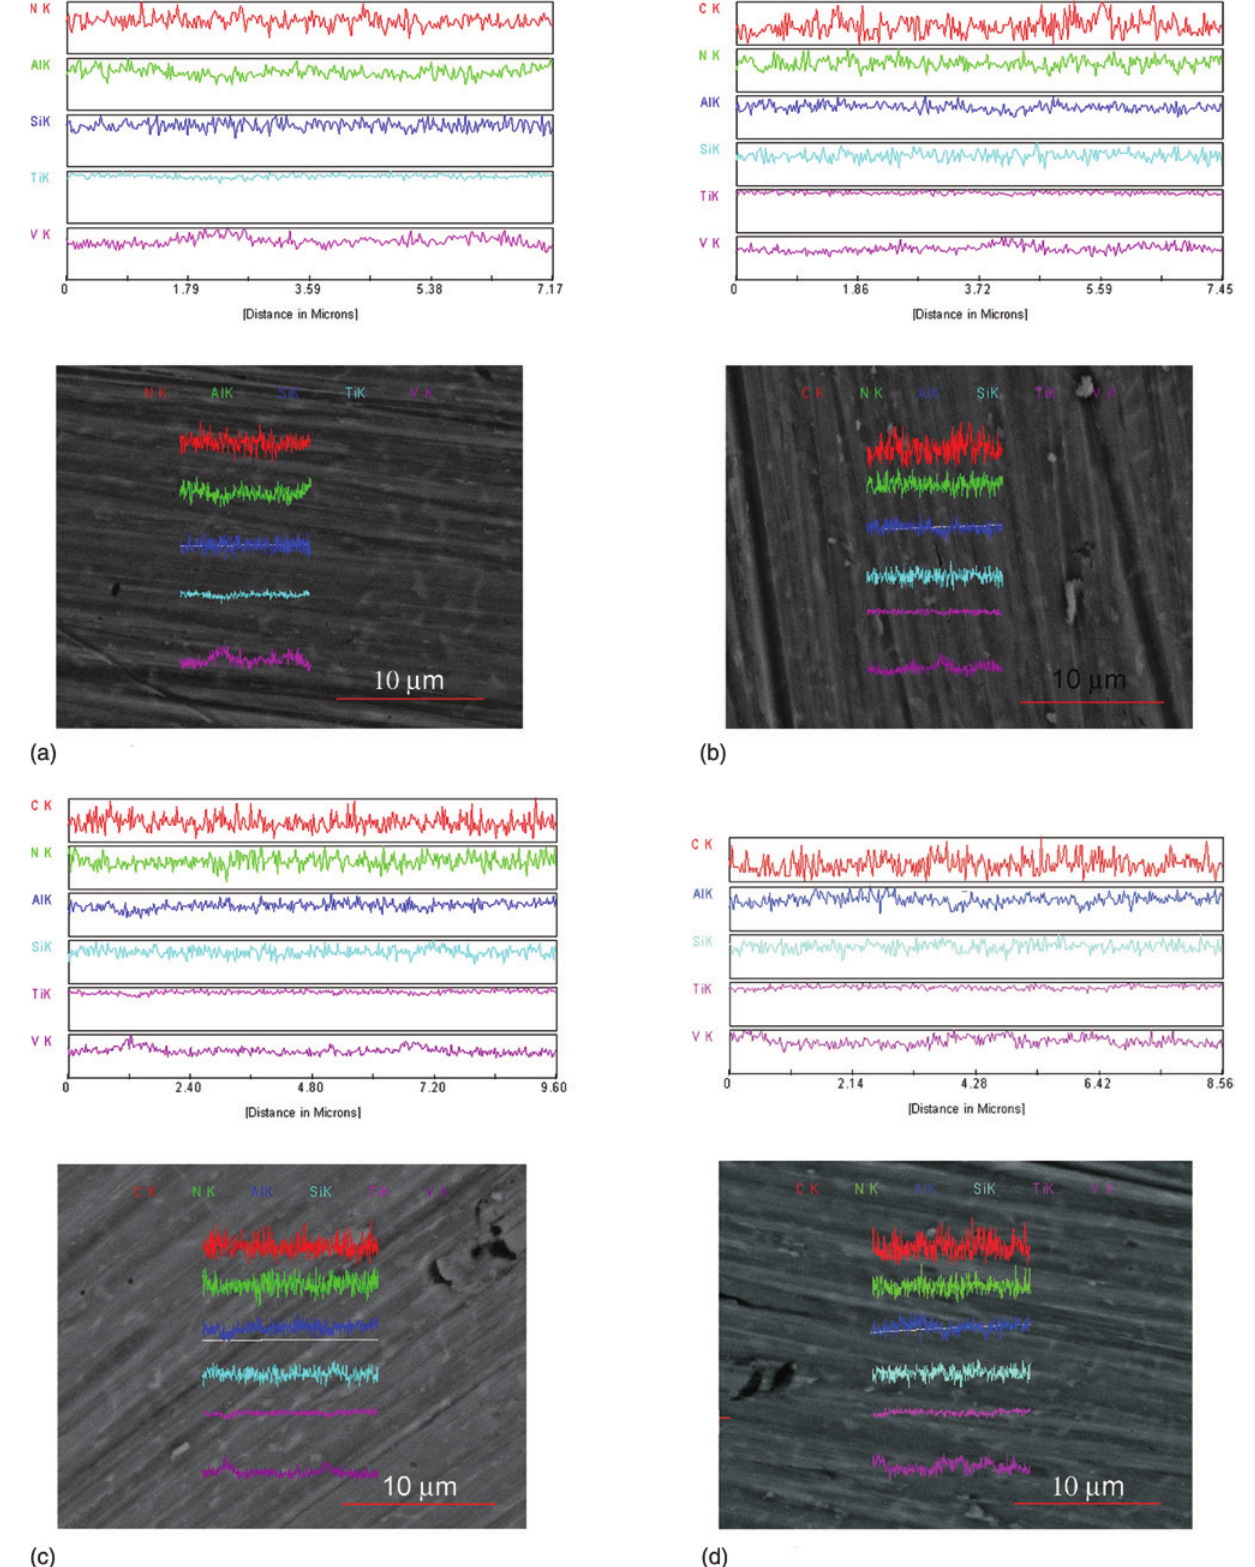
Fig. 2: The linear distribution of elements in the layers: a) Si x N y (H)-series 1, b) SiC x N y (H)-series 2, c) SiC x N y (H)-series 3, d) SiC x (H)-series